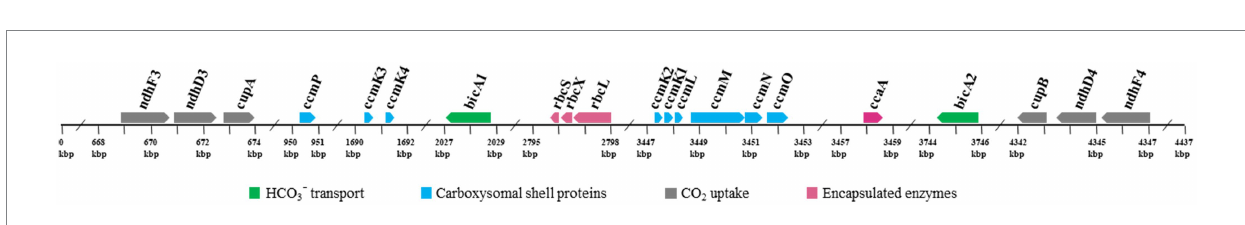
FIGURE 6 Genomic organization of CCM-related genes for Trichothermofontia sichuanensis B231. Solid arrow boxes refer to genes and the direction of